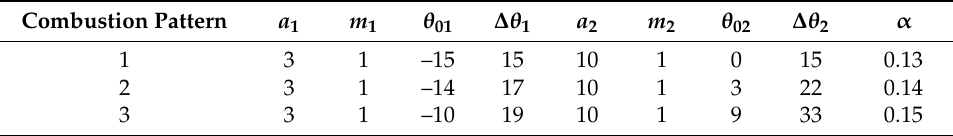
Table 6. Various combustion patterns determined by the double-Wiebe